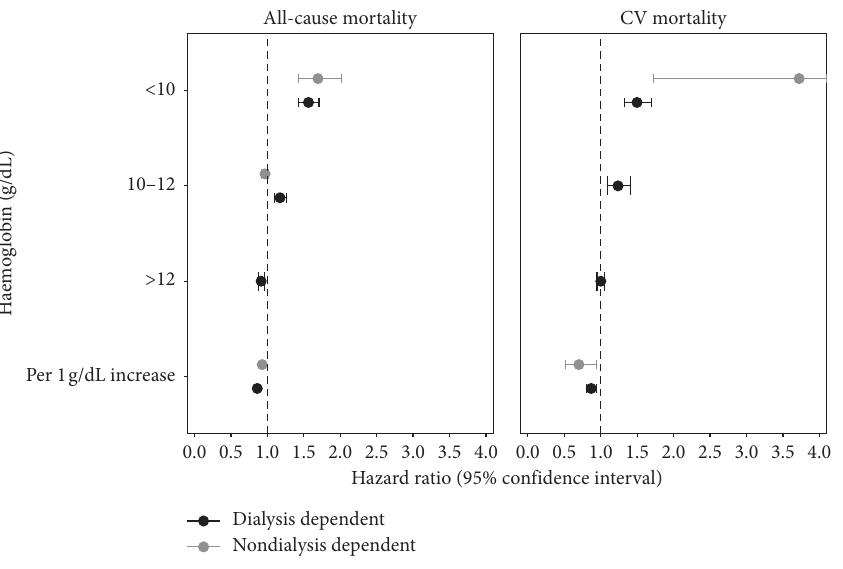
Figure 3: Associations between Hb level and mortality in CKD